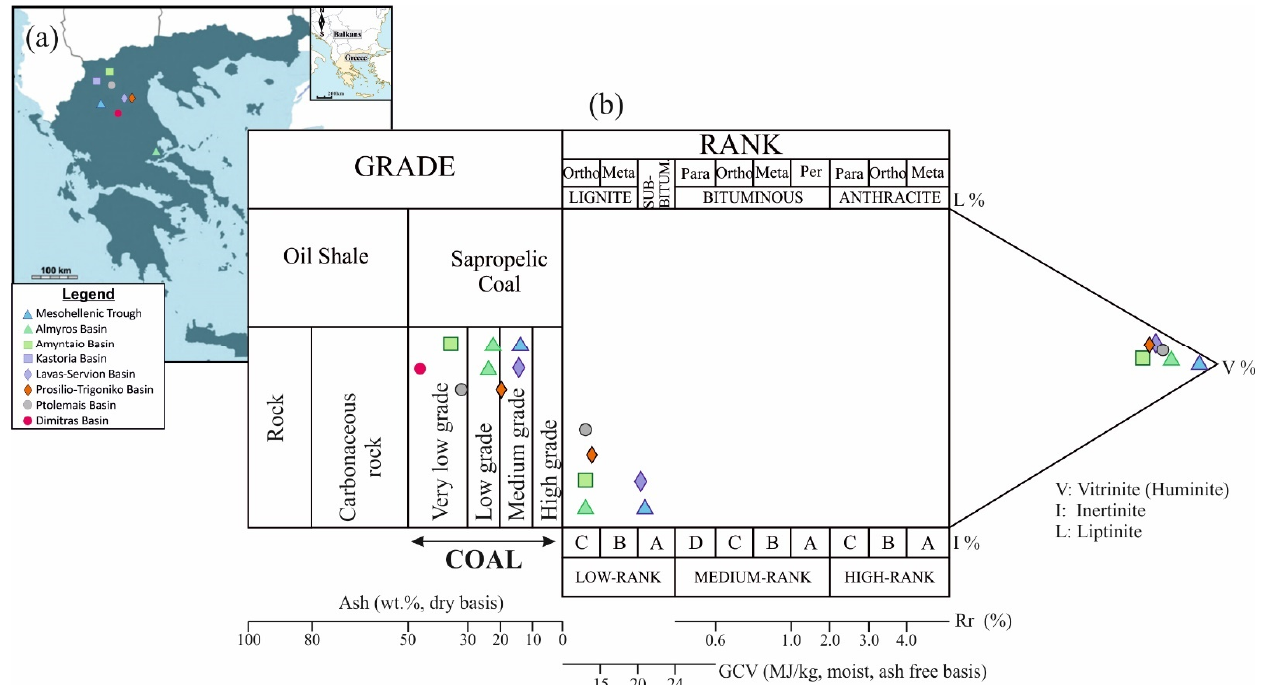
Figure 1. ( a ) Map of Greece indicating the studied coal basins; ( b ) ECE-UN classification of the reviewed coal basins [2] .